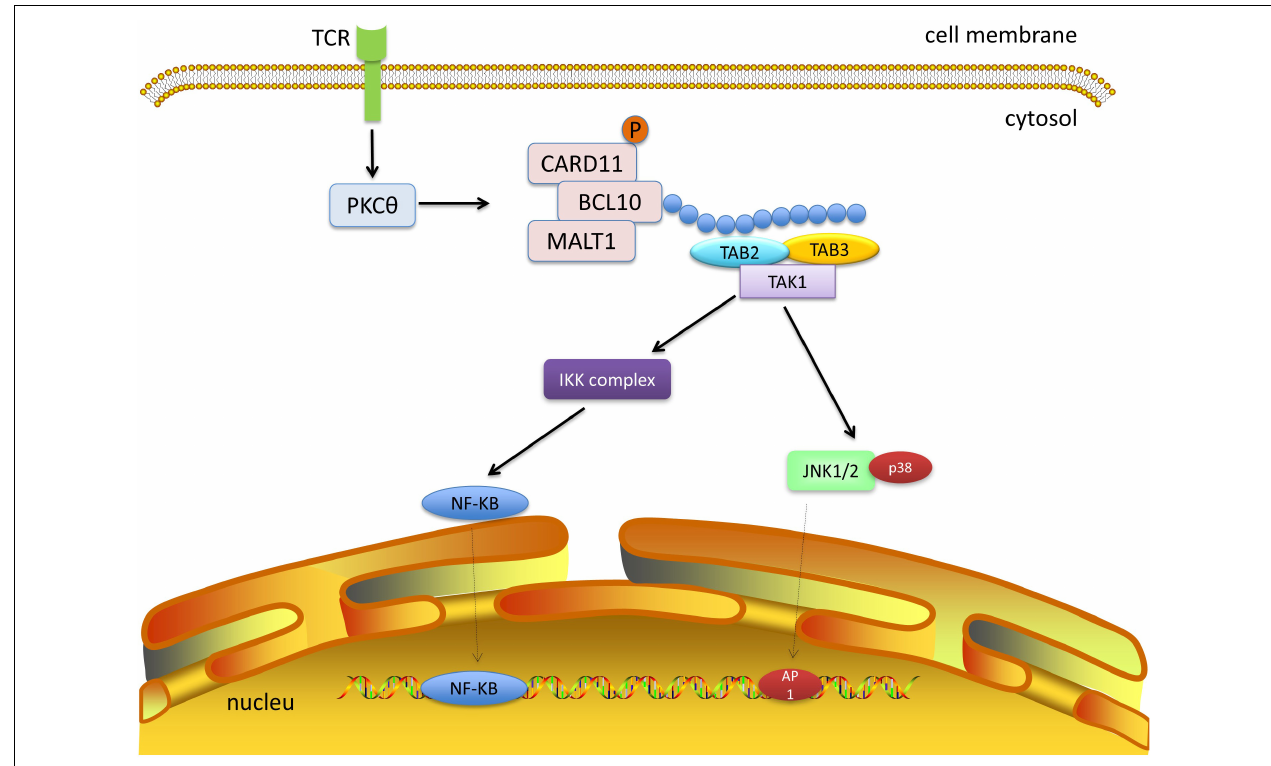
FIGURE 5 | TAK1 and CBM signaling. The protein kinase C θ (PKC θ ) is activated after stimulation of the T-cell receptor. PKC θ phosphorylates CARD11, which subsequently binds to BCL10 and MALT1. The CBM complex recruits E3 ubiquitin ligases to form ubiquitin chains, which provide platforms for TAB2 and TAB3 and recruit TAK1. Next, TAK1 mediates activation of the NF- κ B and MAPK